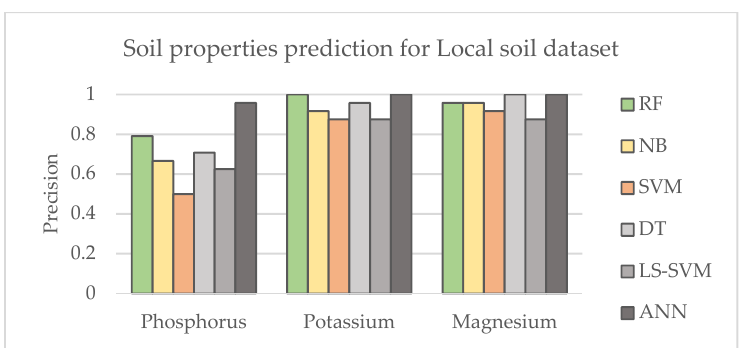
Figure 4. Comparison of the results corresponding to different machine learning techniques for Local soil dataset using Category II system for category labelling.